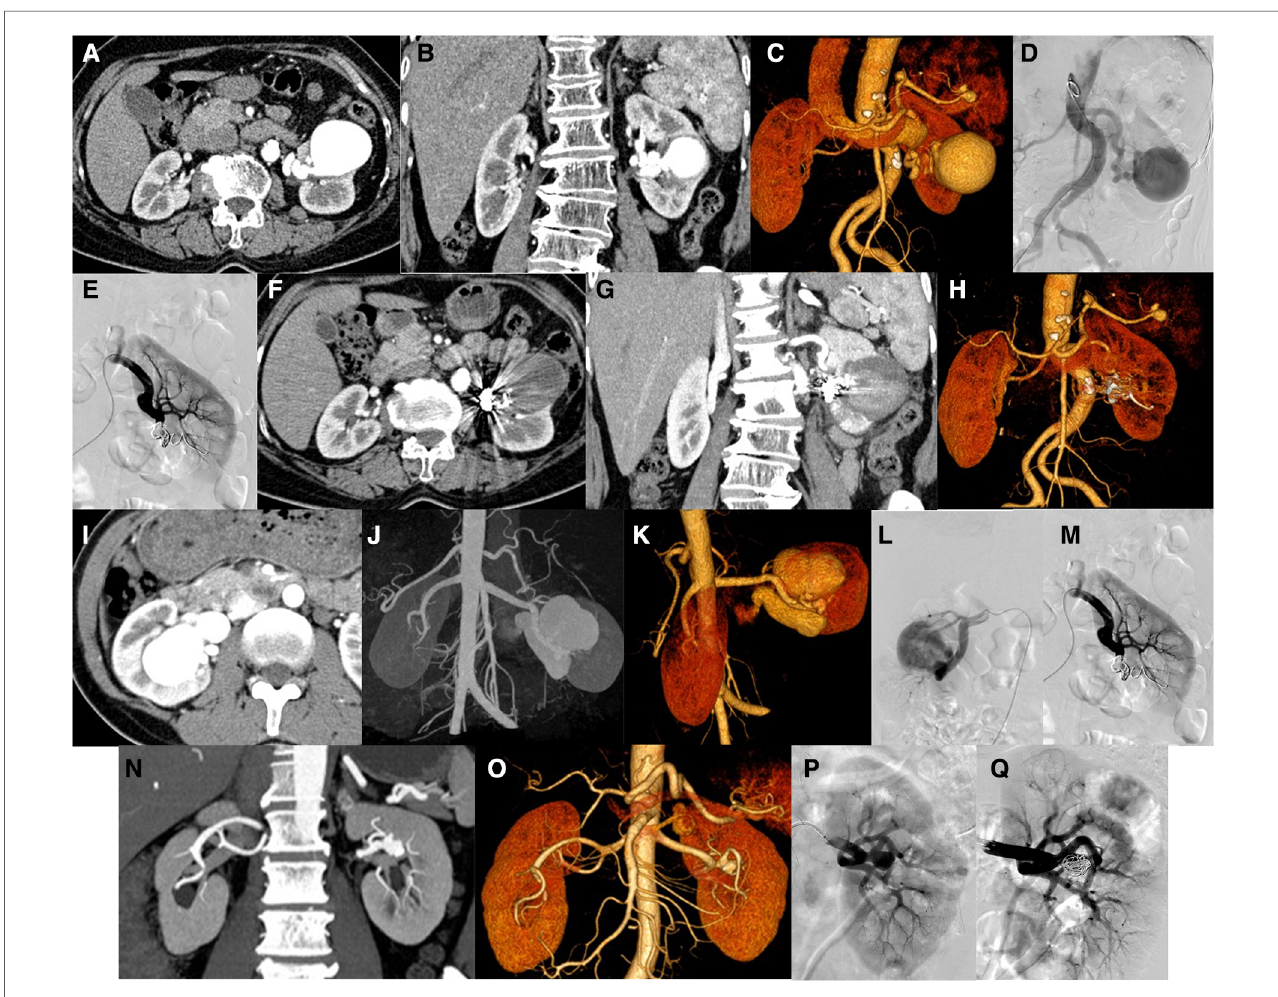
FIGURE 4 Patients no. 6 with renal aneurysm: ( A,B ) Computed tomography (CT) showed that the distal branch of the left renal artery (equivalent to the middle and lower part of the left kidney) showed a cystic dilation (approximately 4.9 cm×4.5 cm×4.9 cm), and multiple tumor-like dilations occurred in the proximal part of the splenic artery and the lumen near the splenic hilum. ( C,D ) An angiogram of the left renal artery showed that the left renal artery thickens, equivalent to a saccular dilated blood vessel (approximately 5.5 cm in diameter) in the lower-left kidney. Left renal aneurysm was considered. After embolization of the blood supply artery with a controllable coil, the above-mentioned saccular dilated blood vessels were not observed after repeated angiography. ( F – H ) Reexamination of the CT scan 1 week after the operation showed that the original distal branch (equivalent to the middle and lower part of the left kidney) showed cystic dilation, but no enhancement was observed. Patients no. 3 with renal aneurysm: ( I – K ) Enhanced CT showed enlargement of the right kidney and lesions in the area of the right kidney. Considering that the arteriovenous malformation may be accompanied by aneurysm-like expansion (maximum diameter approximately 4.7 cm), an arteriovenous fi stula. ( L,M ) An angiogram of the right renal artery showed two large aneurysms in the middle and lower Poles of the right renal artery, whose sizes were 2.2 cm×1.8 cm and 2.3 cm×1.0 cm and they were in series. The responsible blood vessel of the right renal artery was embolized with microspring through the microcatheter, and Glubran was used for embolization. After embolization, the right renal aneurysm disappeared, and the right renal parenchyma was well displayed. Patients no. 13 with renal aneurysm: ( N,O ) Left renal aneurysm (maximum inner diameter of approximately 12.7 mm), and the left adrenal gland with a rich blood supply occupying the space, considering the possibility of pheochromocytoma or adenoma, bilateral repeated renal malformations. ( P,Q ) An angiogram of the left renal artery